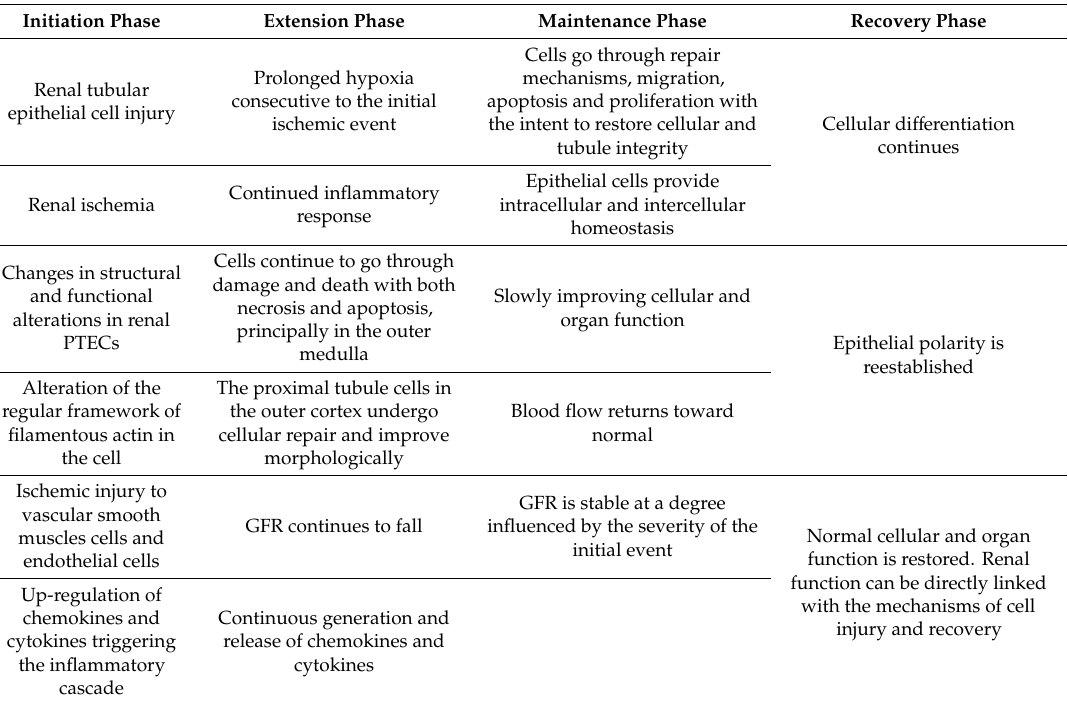
Table 1. Acute tubular necrosis (ATN): di ff erent